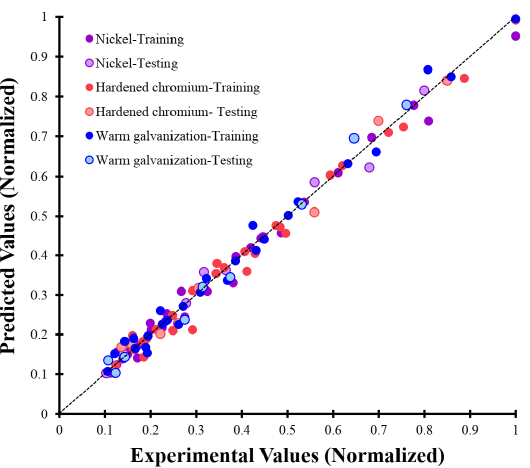
Figure 6. Combined results of training and testing processes for all coating materials comparing the experimental and predicted values.